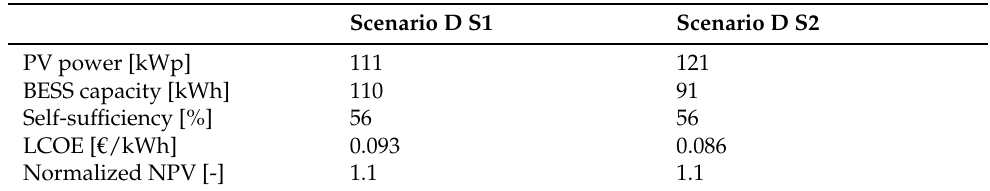
Table 5. Sub-optimal configurations for the Scenario